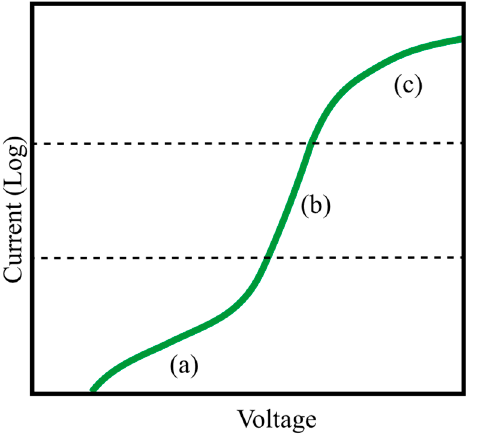
Figure 13. Typical semilog forward voltage behavior of an LED.